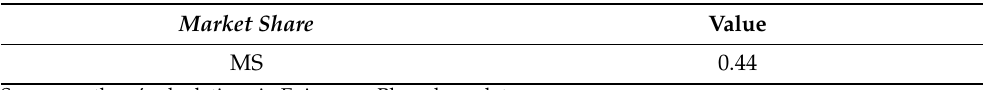
Table 7. Market Share: period of January 2015–December